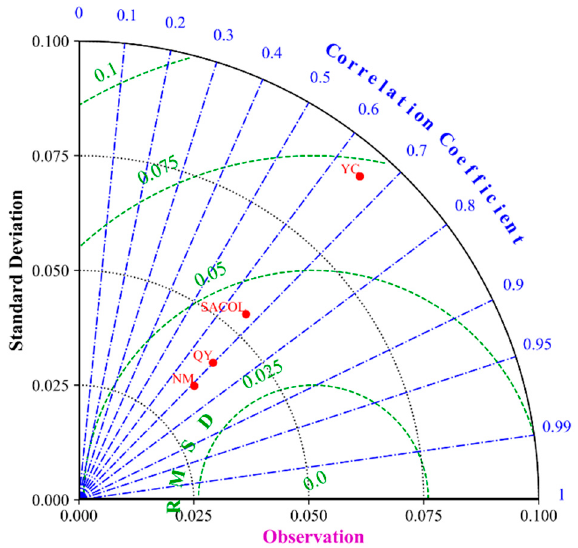
Figure 2. Taylor diagram of ESA CCI soil moisture data.